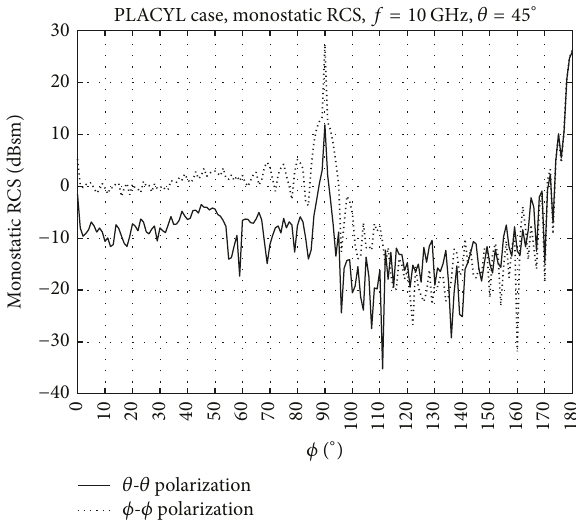
Figure 3: Monostatic RCS results for the PLACYL case, 𝑓 = 10